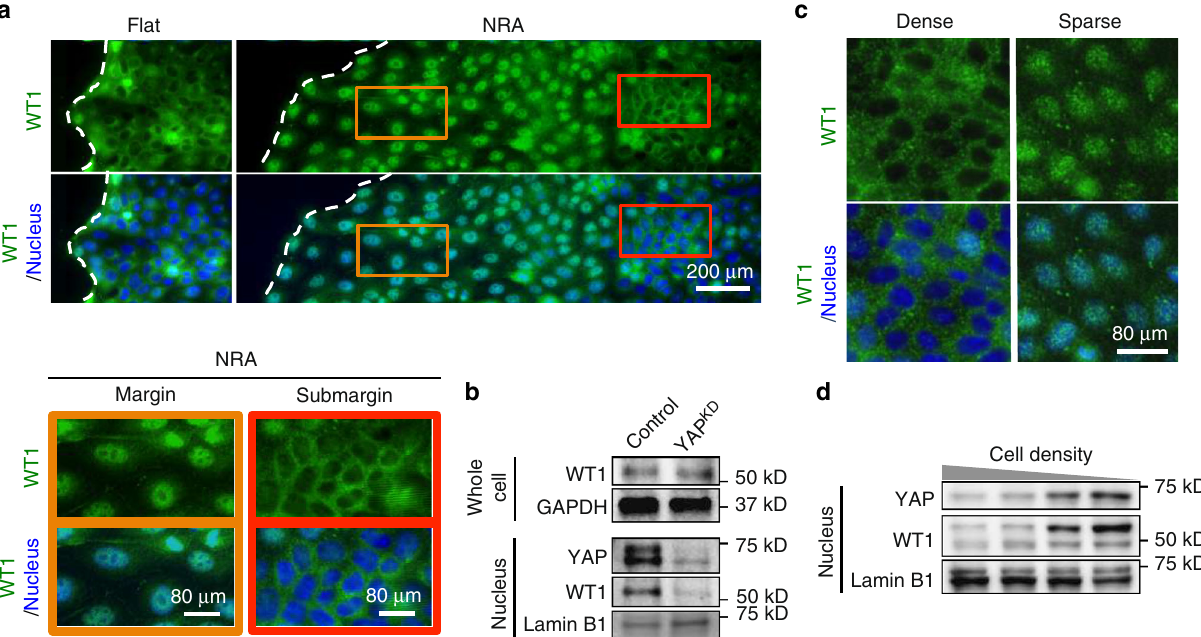
Fig. 3 Similar subcellular localization of WT1 with YAP. a Immuno fl uorescence staining for WT1 in epithelial cell sheets on fl at substrata and NRA. Translocation of WT1 into nuclei was observed in marginal zones and FLPs of sheets expanding on NRA (brown boxes). Submarginal cells on NRA (red boxes) and on fl at substrata showed YAP in the cytoplasm. The samples were fi xed after 8 h to remove stencils. b Control and YAP KD cells and their nuclear fractions were analyzed using immunoblotting using YAP and WT1 antibodies. c Immuno fl uorescence staining for WT1 in cells and d immunoblotting of YAP and WT1 abundance in the nuclei in different density – epithelial cell sheets showing density-dependent translocation of WT1 into the